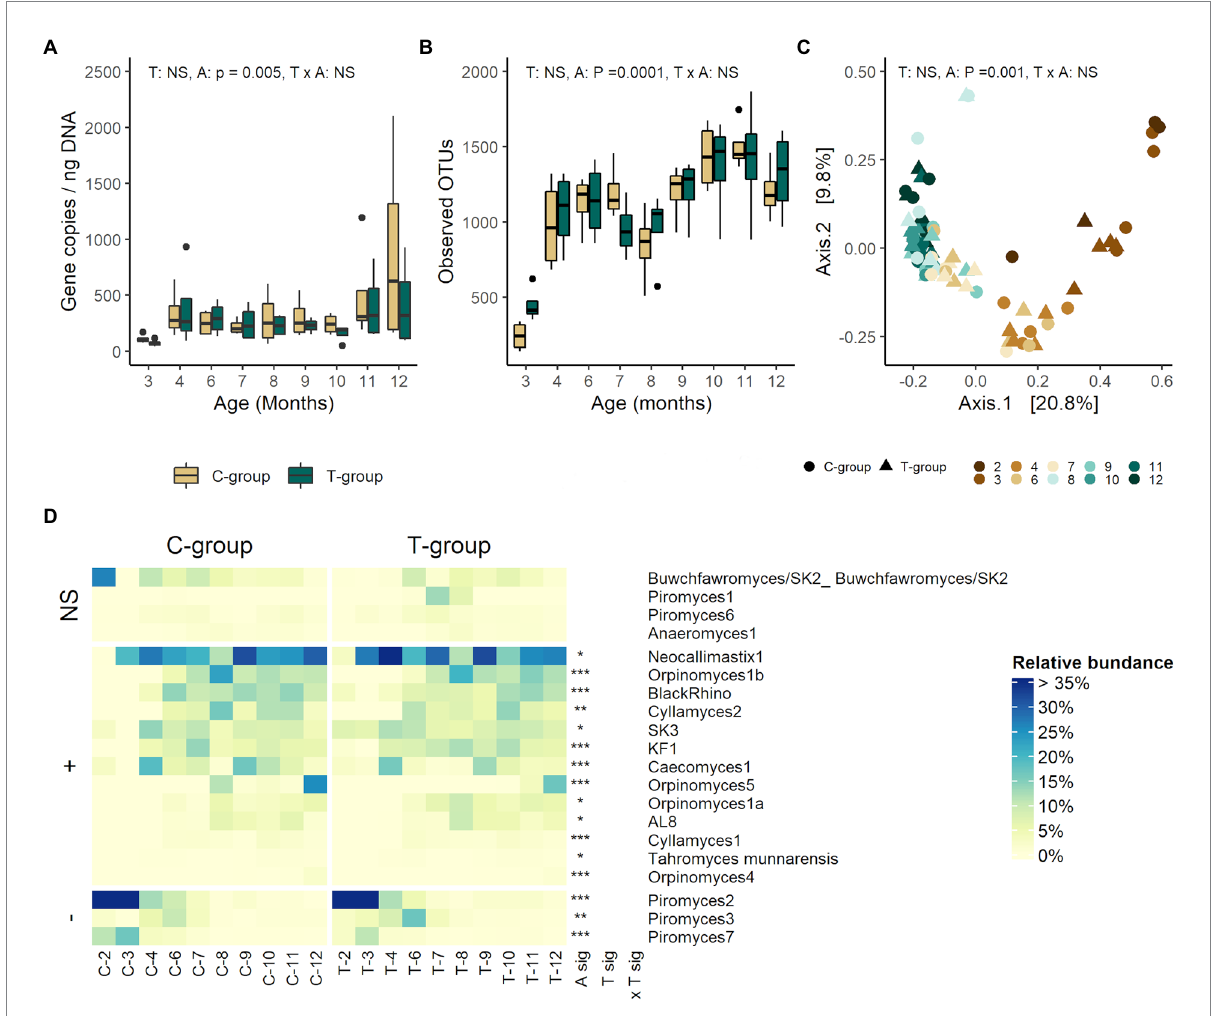
FIGURE 4 The rumen anaerobic fungi community in treatment (T-group) and control (C-group) heifers at 2–12 months of age. (A) The rumen anaerobic fungi ITS1 area copy numbers, (B) the number of observed OTUs, (C) principal coordinate analysis visualization of Bray-Curtis community distances, and (D) the relative abundances of protozoa species. Only taxa with statistical significances are shown. The taxa are grouped by increasing (+) or decreasing ( − ) trend with time, and with no significant effects (NS). Statistical significance of Treatment (T-sig), Age (A-sig), and Treatment × Age interaction (T × A sig): p < 0.05: *, p < 0.01: **, p < 0.001: